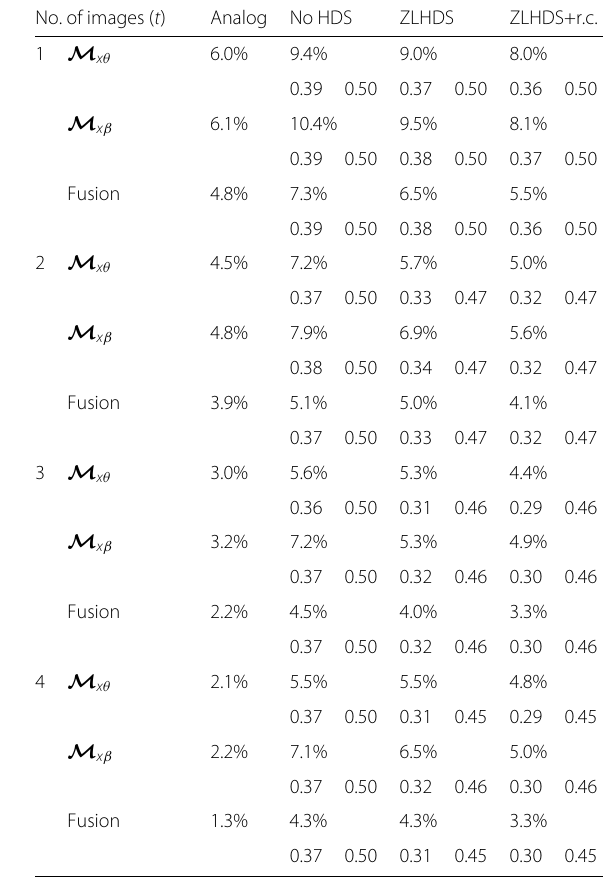
Table 2 EERs and BERs for the FVC2000